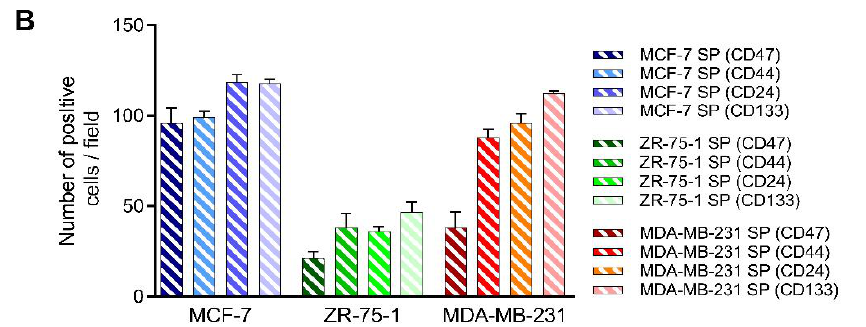
Figure 11. Expression of CD47, CD44, CD24, and CD133 stem cell markers on 3D stem-like derived spheroid breast tumor xeno- grafts. Parafilm sections (5 µm) from xenografts generated from MCF-7, ZR- 75-1, and MDA-MB-231 spheroids were stained using a primary antibody against CD47 (1:50), CD44 (1:50), CD24 (1:50), or CD133 (1:200). ( A ) Images were taken using a light microscope. ( B ) Graph of the number of positive stem cell marker immunostained cells per field ±SEM; three independent experiments performed in triplicates.